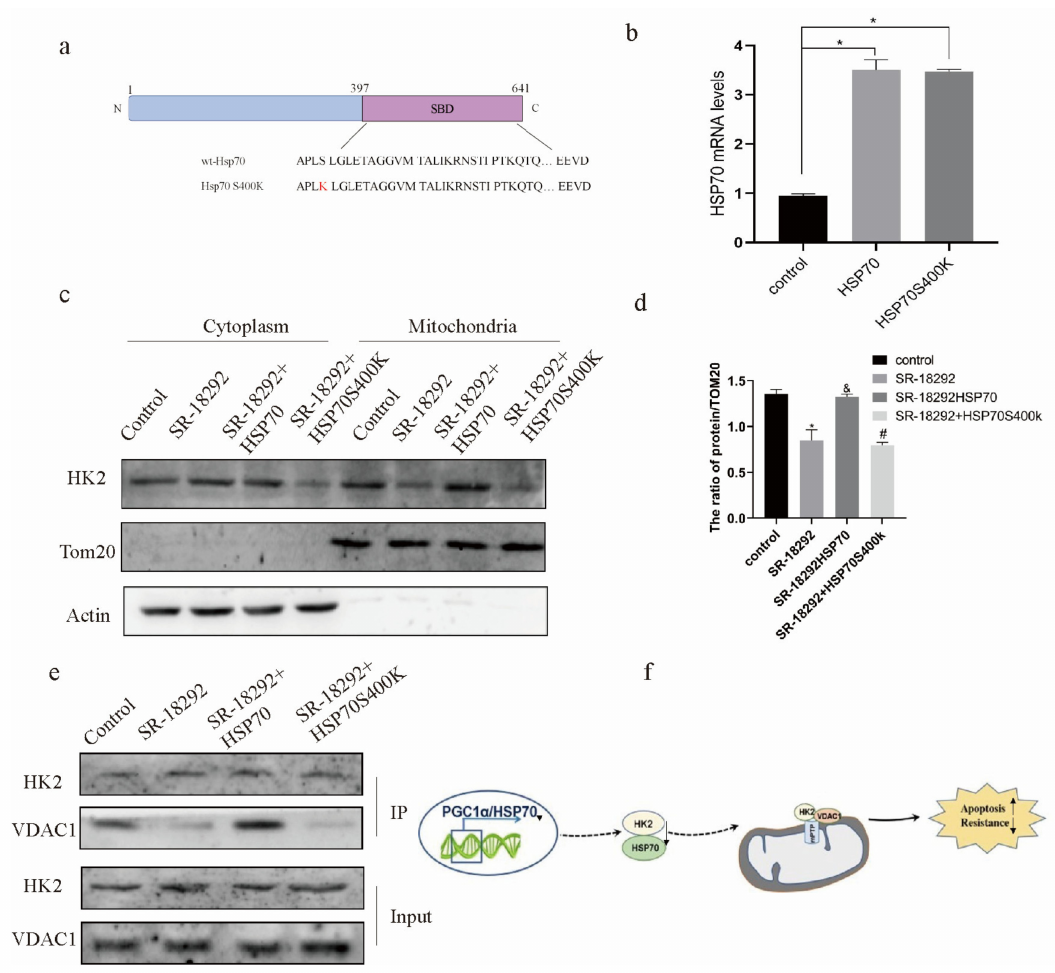
Figure 5. PGC1 α manages the mitochondrial expression of HK2 and glycolysis through HSP70. We mutated serine at 400 sites of HSP70 into lysine ( a ). The mRNA level of HSP70 was verified by qPCR and expressed as the mean ± SD; n = 3, * p < 0.05 vs. control ( b ). The effect of the overexpression of HSP70 and HSP70 S400K on the expression level of HK2 mitochondria was detected by a mitochondrial extraction experiment ( c ). The protein/TOM20 ratio is expressed as the mean ± SD; n = 3, * p < 0.05 vs. control, & p < 0.05 vs. SR-18292 and # p < 0.05 vs. SR-18292+HSP70 ( d ). Immunoprecipitation was used to detect the binding of HK2 to VDAC1 after SKOV3/CDDP cells were treated and expressed as the mean ± SD; n = 3 ( e ). Therefore, we speculate that PGC1 regulates the binding of HK2 to VDAC1 through HSP70, and then affects the cisplatin resistance of ovarian cancer ( f